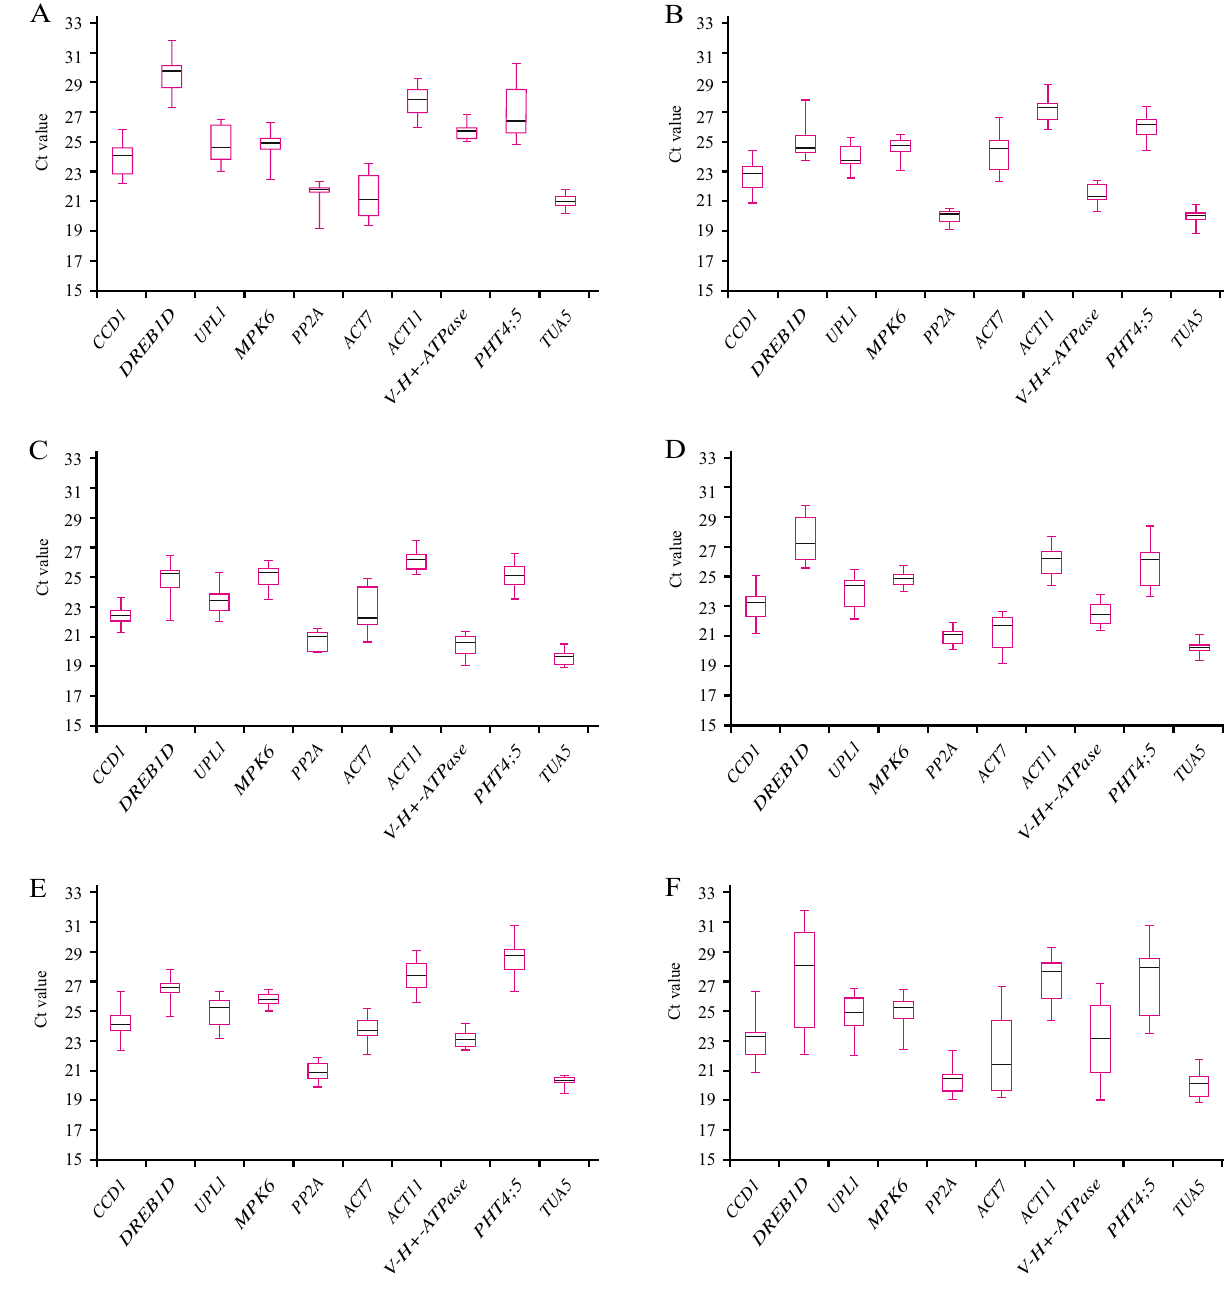
Figure 1. Boxplots showing the expression patterns of candidate reference genes of S. glauca represented by raw Cq values. The box indicates the 25th and 75th percentiles, and whisker caps represent the maximum and minimum values. The black line across the box depicts the median. ( A ) Thirteen tissue samples derived from 1/10 MS liquid medium treatment. ( B ) Thirteen tissue samples derived from 100 mM NaCl treatment. ( C ) Thirteen tissue samples derived from 300 mM NaCl treatment. ( D ) Fifteen germinating seed samples derived from NaCl gradient treatment. ( E ) Eighteen seedling samples derived from NaCl gradient treatment. ( F ) All 72 samples used in this